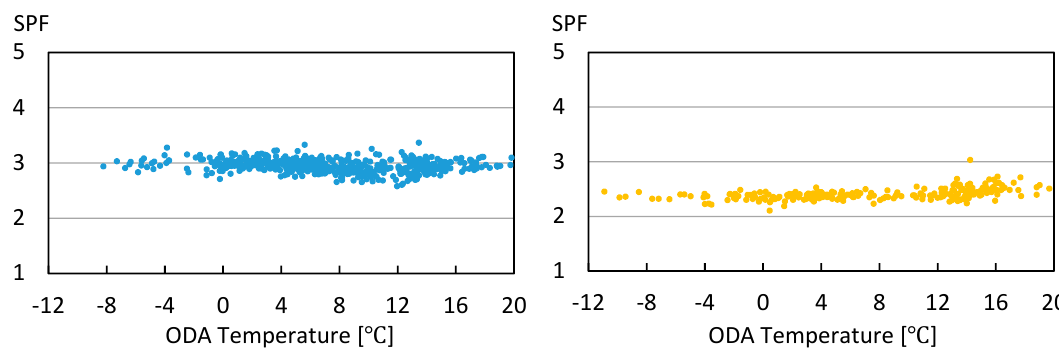
Figure 25. Daily SPF 3 values for hot water plotted against outdoor air temperatures for medium ( left ) and high ( right ) pump speeds.